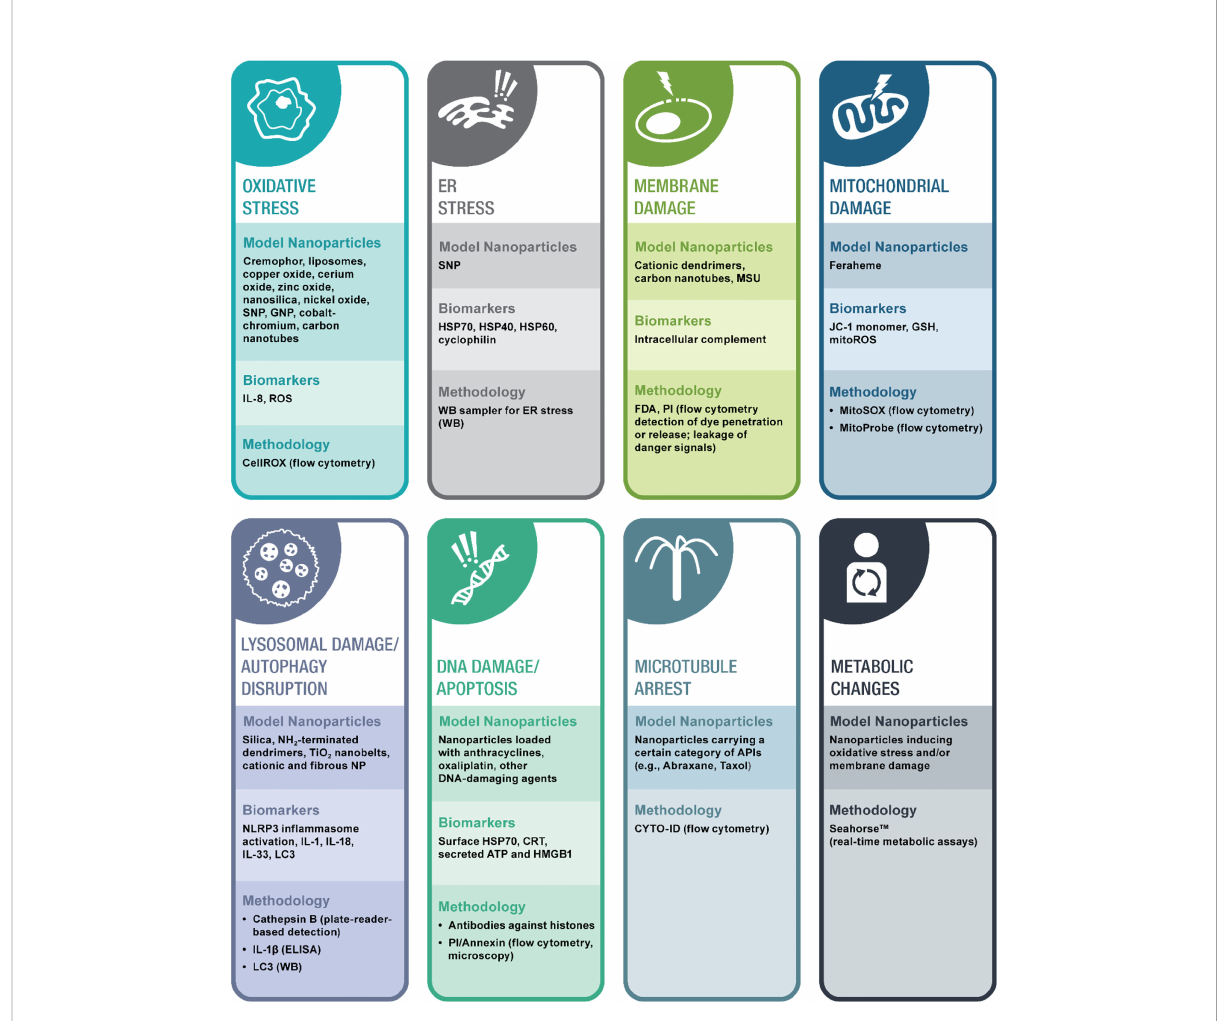
FIGURE 9 A framework of mechanistic studies. Types of mechanistic studies, model nanoparticles that could be used as controls, methodologies, and intrumentation, and, whenever available, relevant biomarkers are summarized. API, active pharmaceutical ingredient; ATP, adenosine triphosphate; CRT, calreticulin; ER, endoplasmic reticulum; ELISA, enzyme-linked immunosirbent assay; FDA, fl uorescein diacetate; GNP, gold nanoparticles; GSH, glutathion; Histones, Phospho-Histone H2AX (Ser139); HSP, heat shock protein; HMG, high mobility group; ID, identi fi er; LC, light chain; MSU, monosodium urate; NP, nanoparticles; PI, propidium iodine; ROS, reactive oxygen species; SNP, silver nanoparticles; TM, trade mark; WB, western